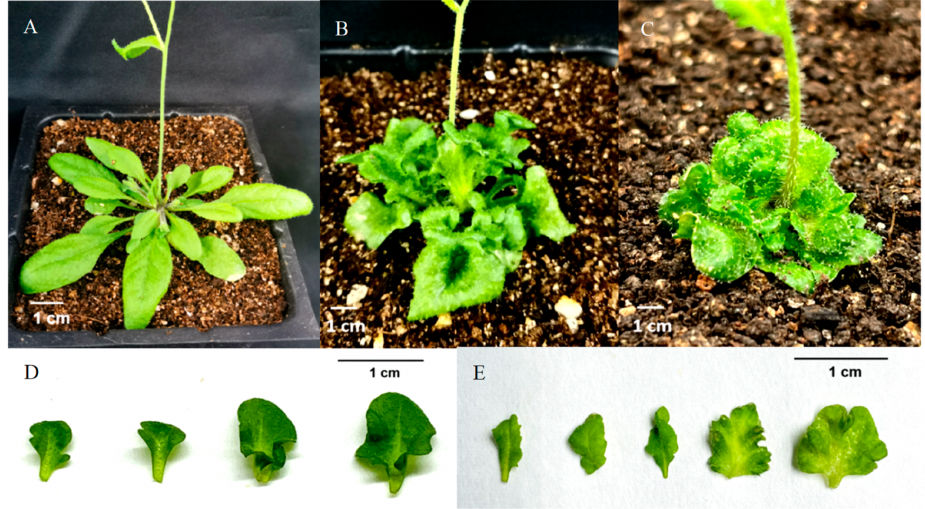
Figure 9. Phenotype observation of Arabidopsis plant overexpressing chrysanthemum KNOX gene (( A ) shows wild type Arabidopsis plant; ( B , D ) show the front view and leaves of Arabidopsis plant overexpressing chrysanthemum CmKNAT1 gene; ( C , E ) show the front view and leaves of Arabidopsis plant overexpressing chrysanthemum CmSTM